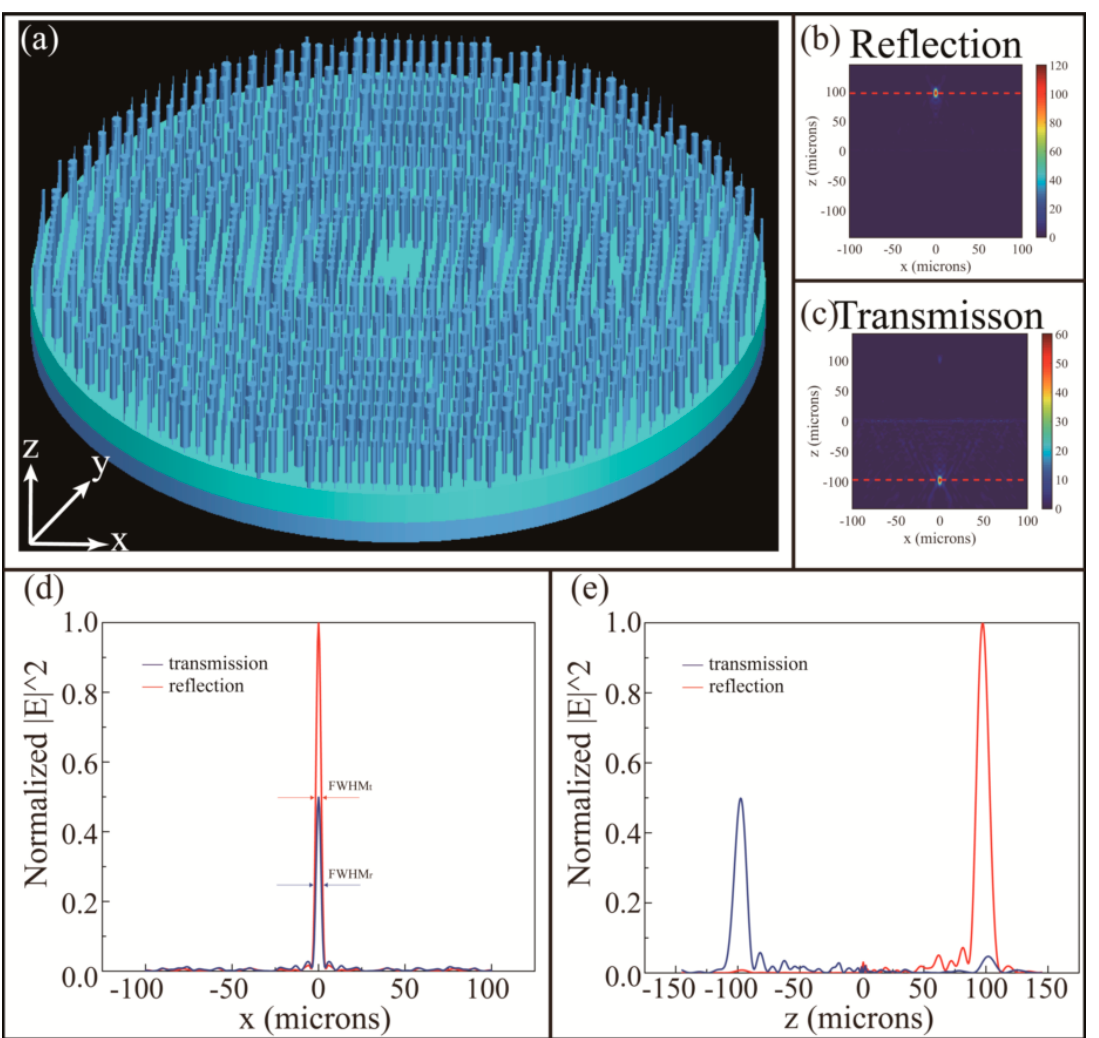
Figure 5. ( a ) The array structural diagram of metalens; ( b ) reflection and ( c ) transmission electric field strength | E | 2 of far field detection in the xz -plane with the working wavelength 4 µ M. The position of focus is indicated by red dotted lines. ( d ) Normalized distribution of electric field intensity on the focal plane ( y = 0) and the arrows indicate the FWHM; ( e ) normalized distribution of the electric field intensity on the propagation plane (x = 0).